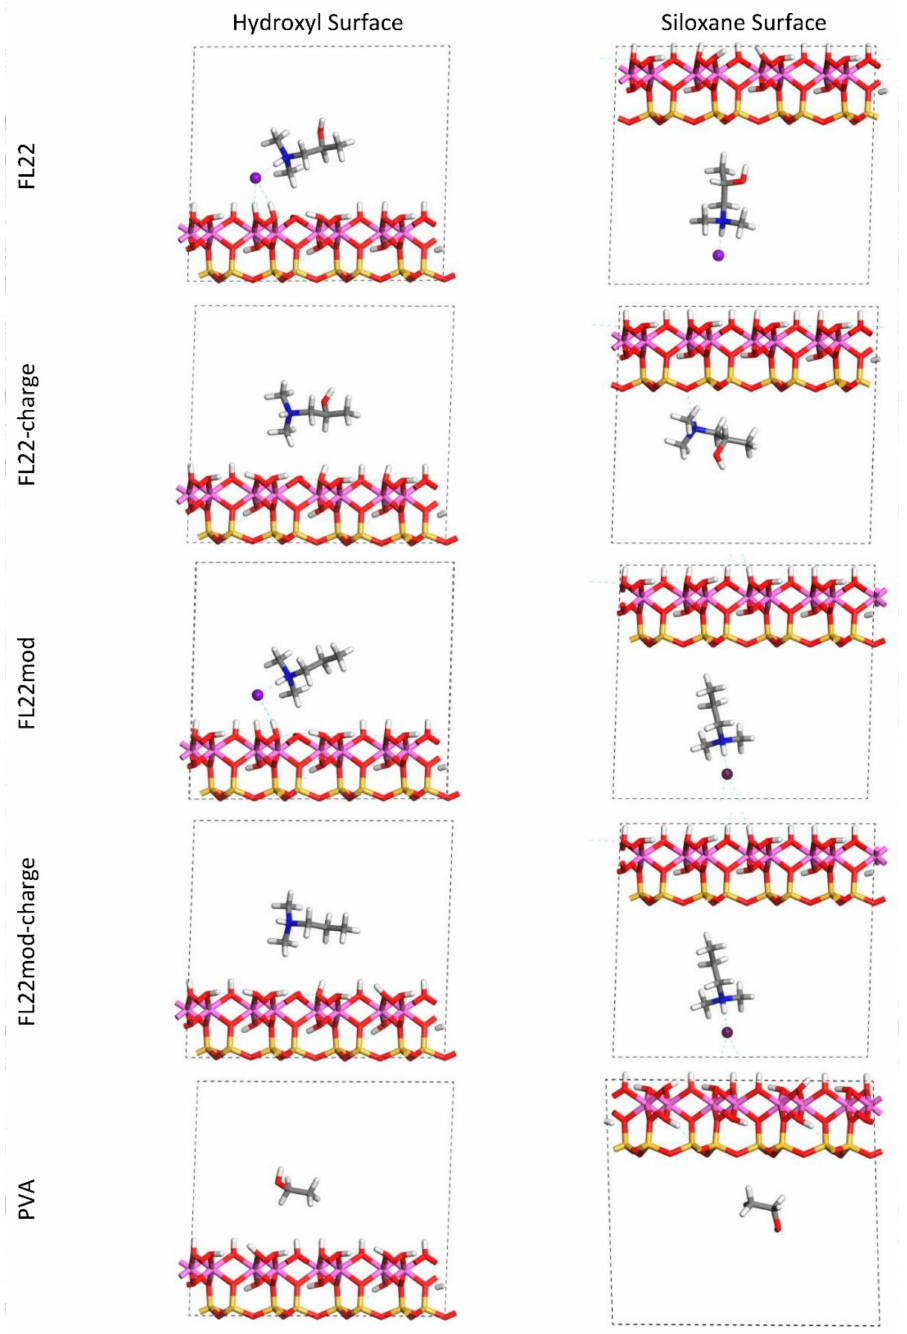
Figure 9. Orientation 1 (o1)—configurations after relaxation of the simulated monomer unit and kaolinite surface in the chloride